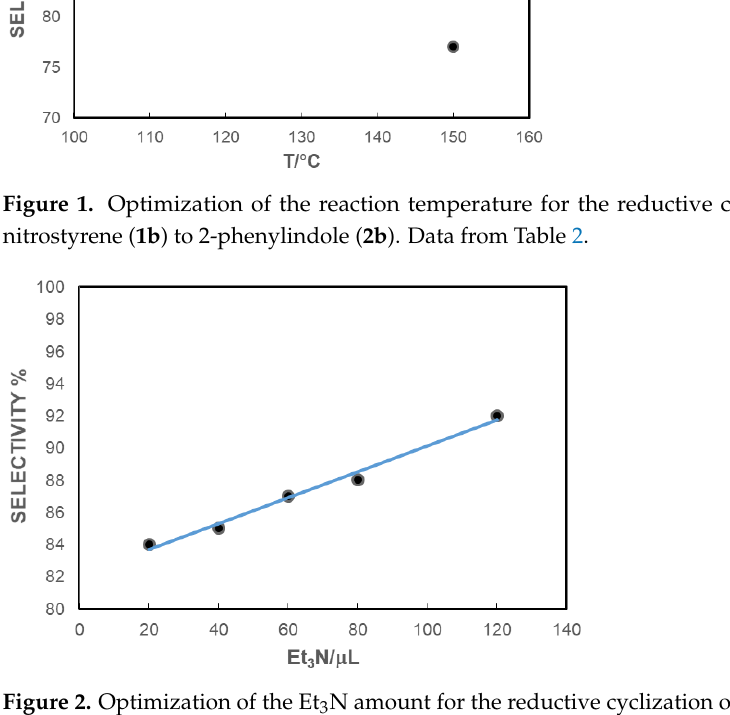
Figure 1. Optimization of the reaction temperature for the reductive cyclization of α-phenyl-β-ni- trostyrene ( 1b ) to 2-phenylindole ( 2b ). Data from Table 2.